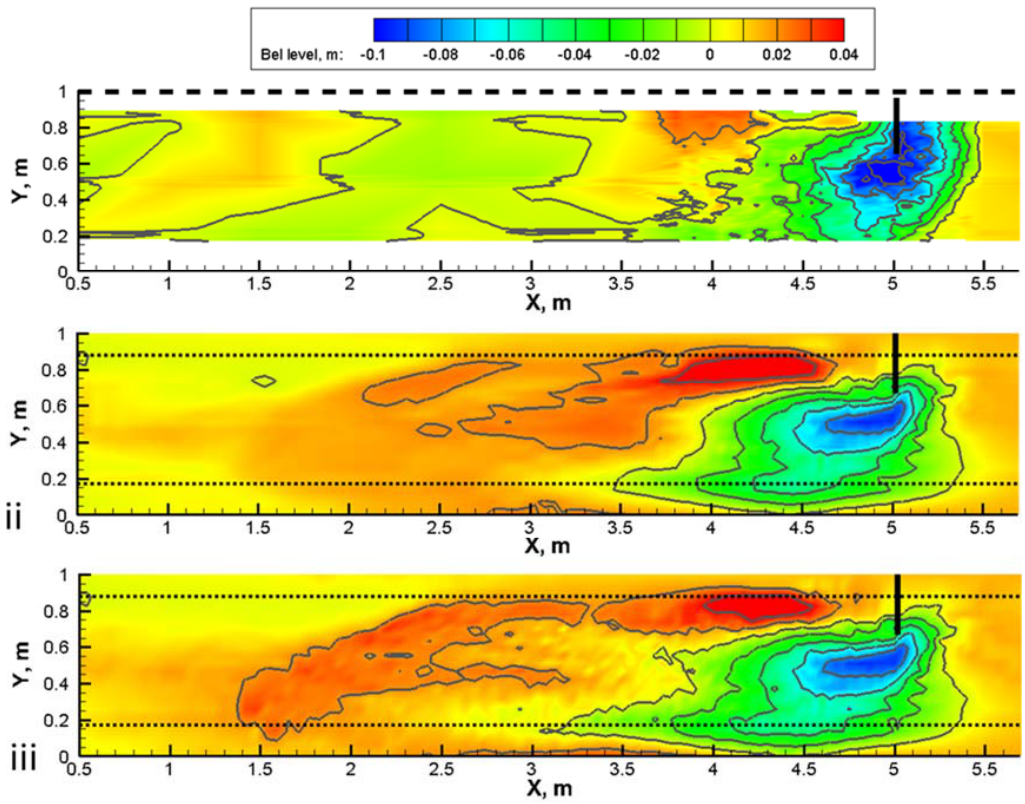
Figure 13. Measured and simulated equilibrium bed levels at Q = 100 L/s. (top: measured; ii: Wilcock and Crowe formula; iii: combined approach).